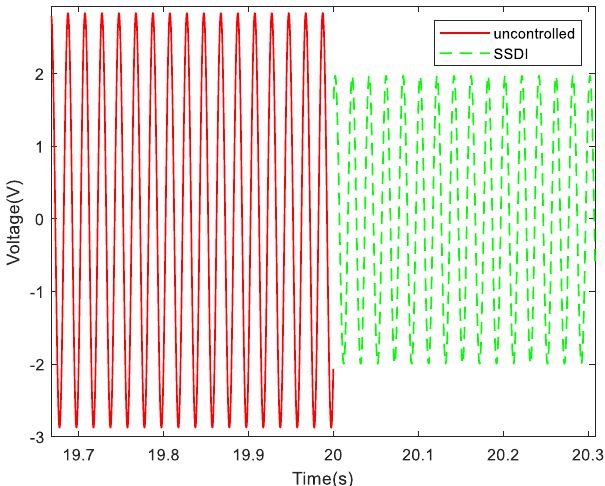
Figure 13. Displacement comparison curves (indicated by the voltage of PZT2) in time domain with and without SSDI (50 Hz).